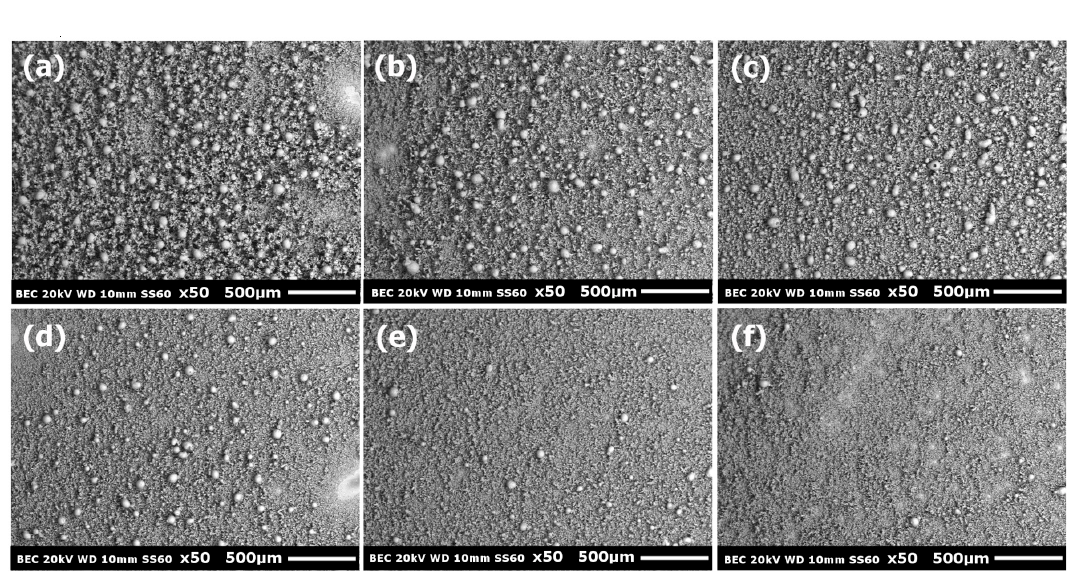
Figure 6. Results of scanning electron microscopy (SEM) 50× of ( a ) undoped ZnO film, and ZnO:Ta-doped films grown with a pellet weight of ( b ) 50 mg, ( c ) 100 mg, ( d ) 200 mg, ( e ) 250 mg, and ( f ) 300 mg of Ta 2 O 5 .